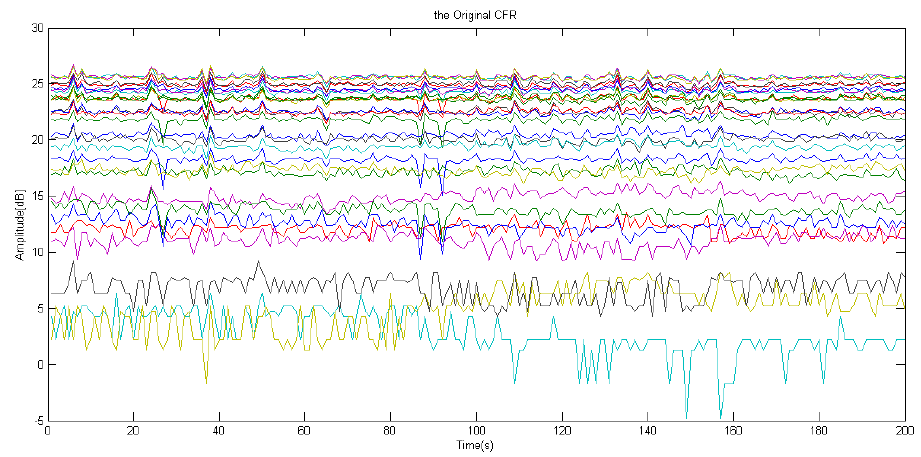
Figure 3. Raw CFR (channel frequency response) for coughing using C-Band.